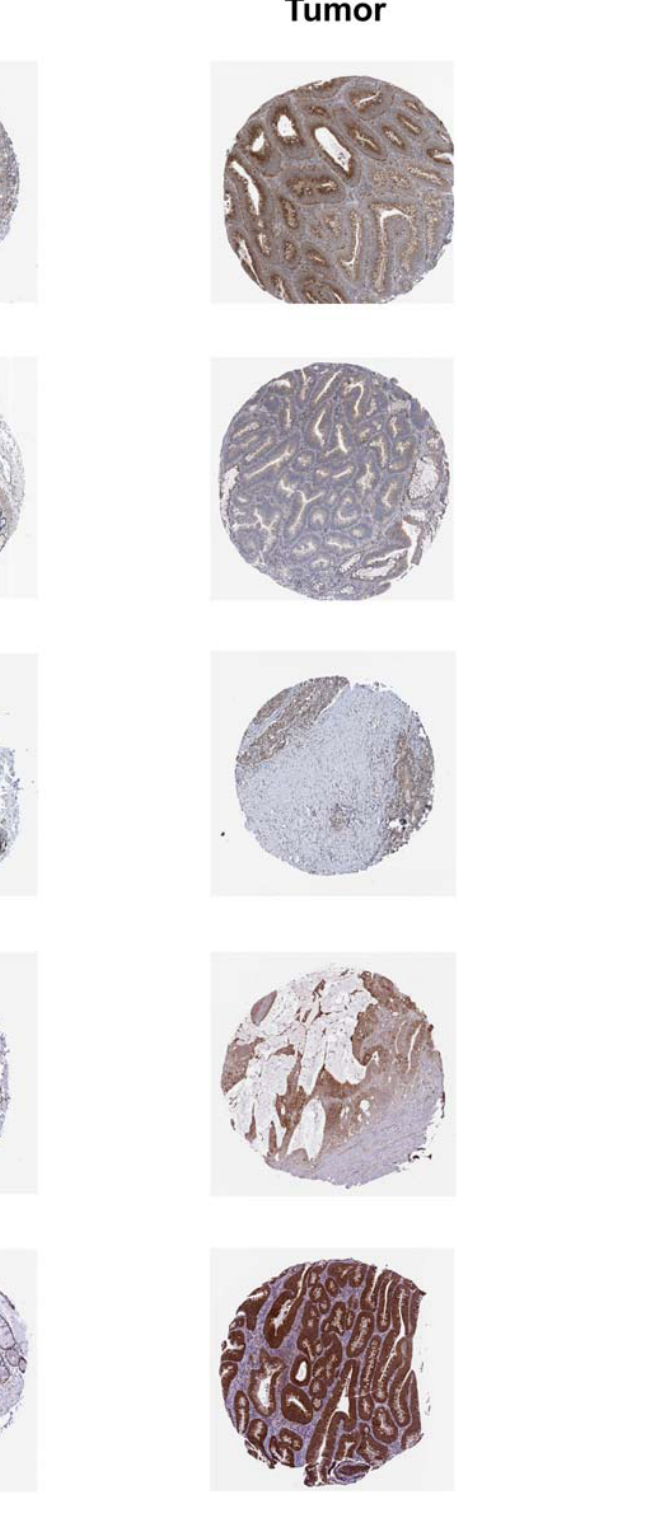
Frontiers in Cell and Developmental Biology |